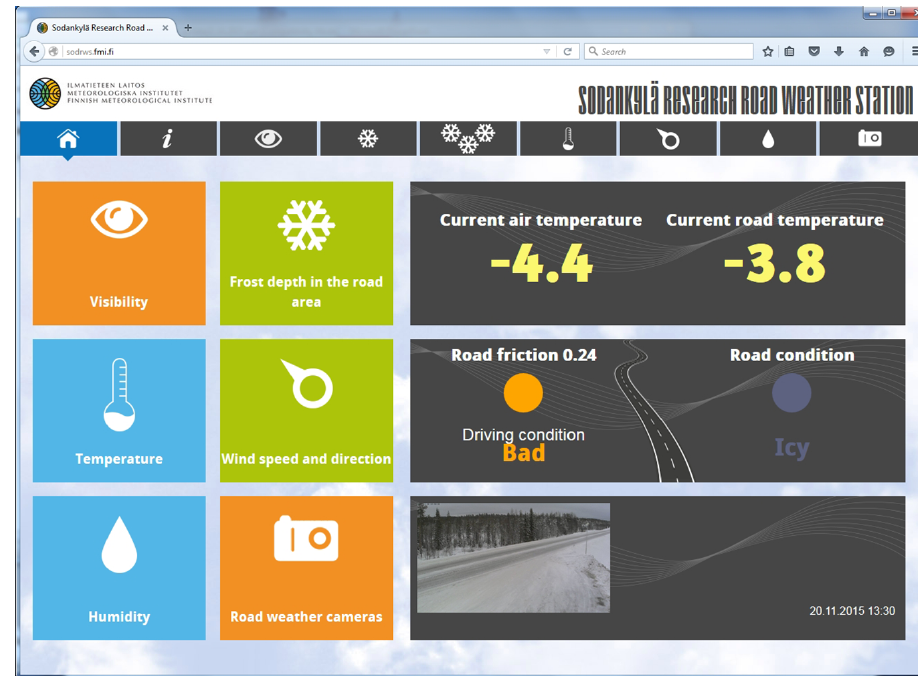
Figure 7. Road weather station website at http://sodrws.fmi.fi